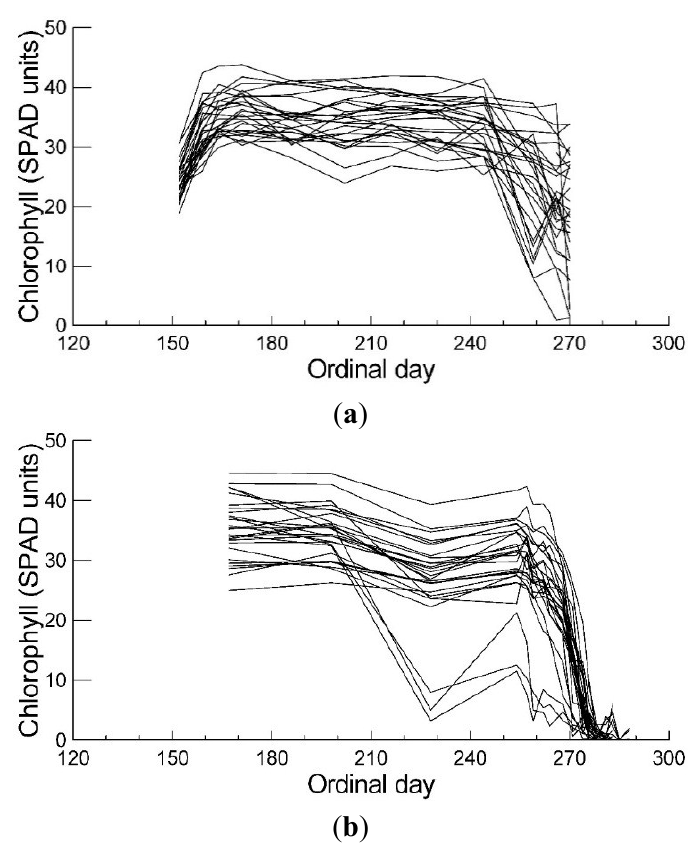
Figure 3. Leaf chlorophyll concentrations in the 27 investigated Acer rubrum trees during 2005 ( a ) and 2006 ( b ) expressed as